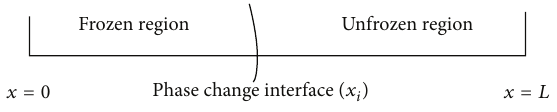
Figure 1: Schematic representation of one-dimensional